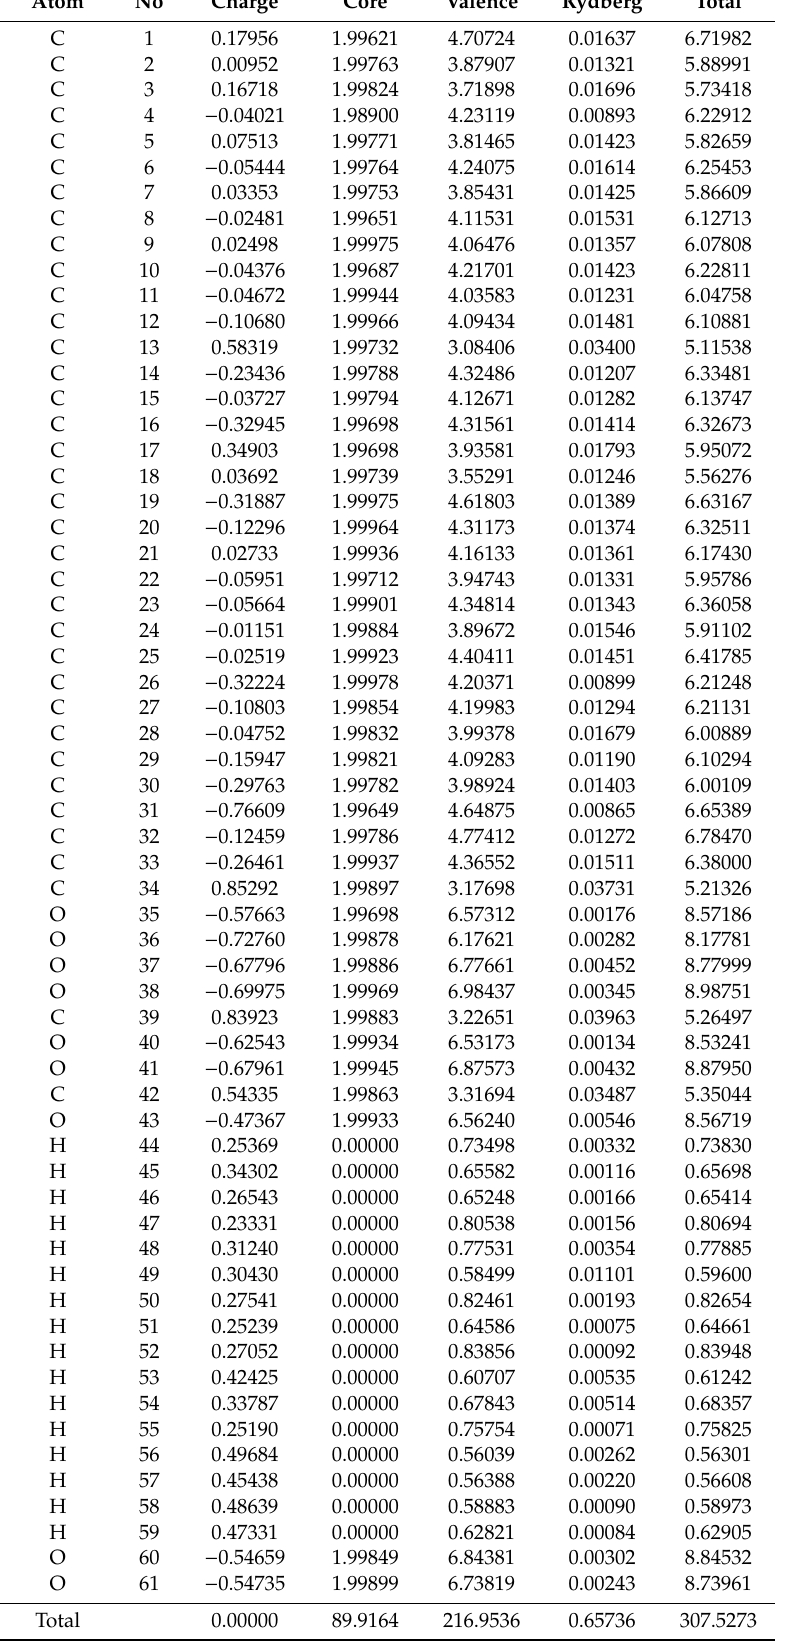
Table 7. Summary of natural population